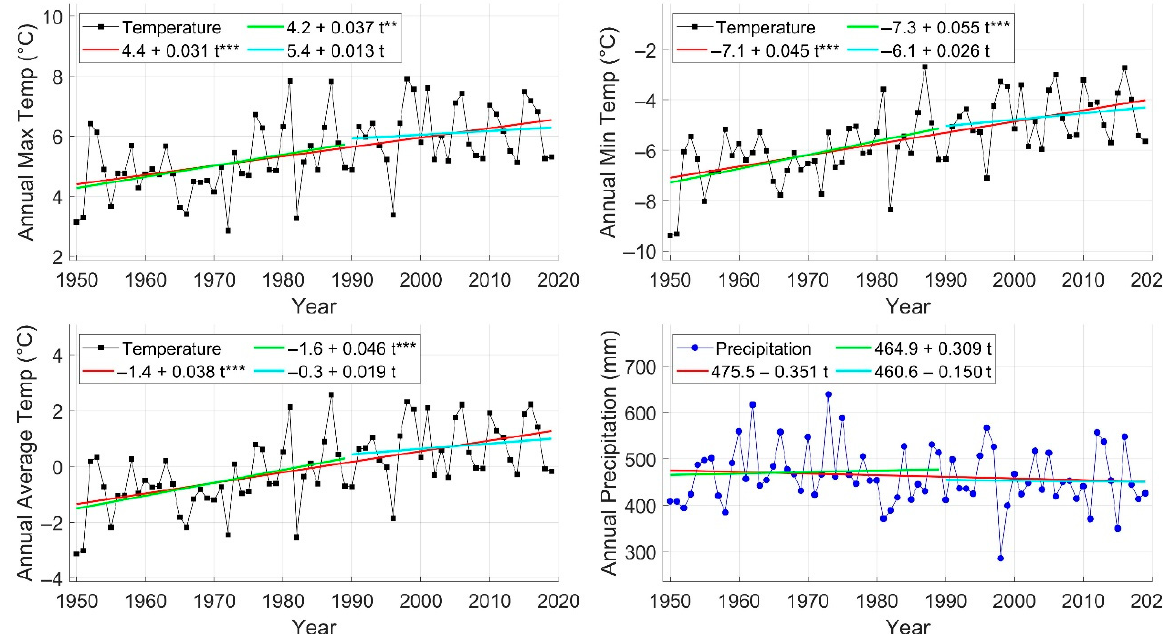
Figure 3. Climate trend analysis results for the lower ARB. The statistically significant slopes are marked by stars: (** = 95%), (*** = 99%).